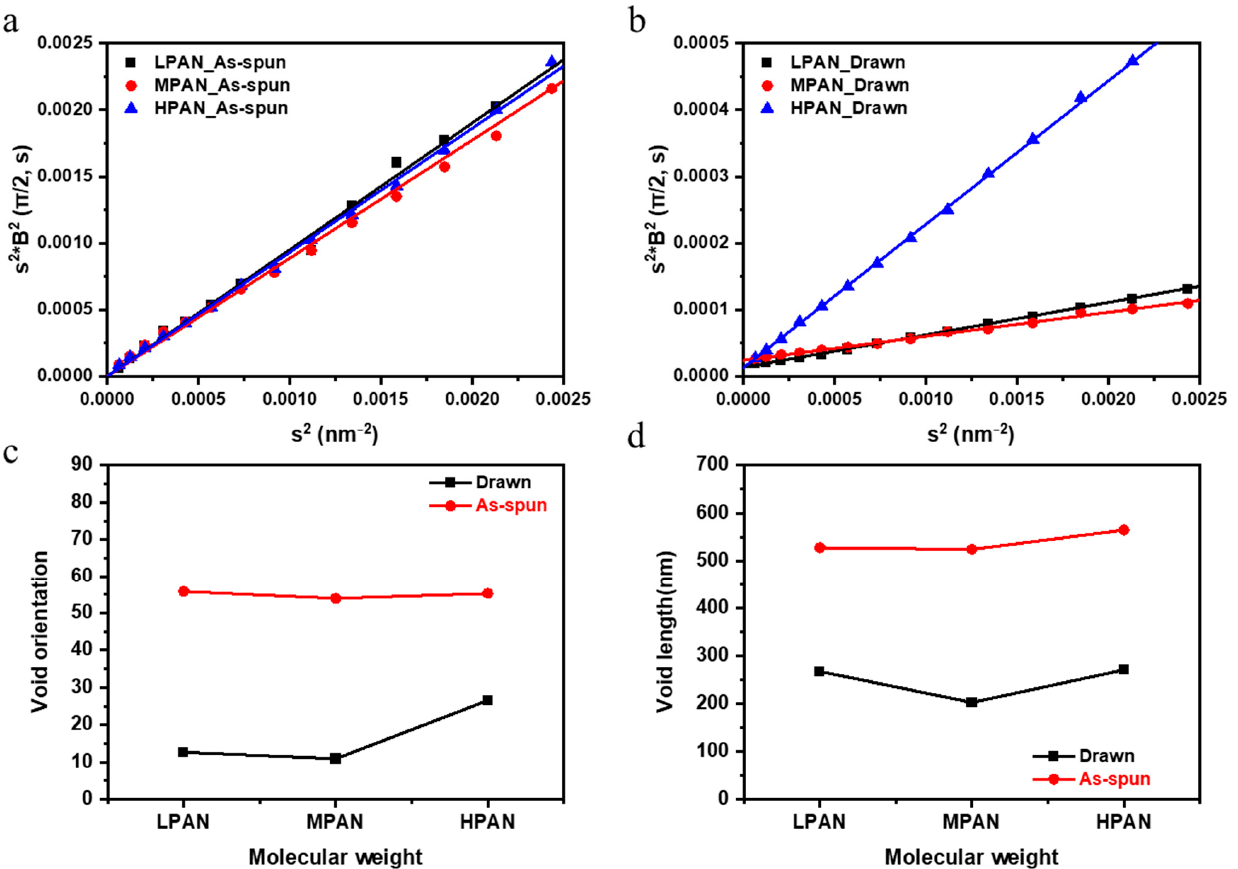
Figure 8. Two-dimensional small-angle X-ray scattering (SAXS); Ruland’s streak data for ( a ) as-spun fibers, ( b ) drawn fibers, ( c ) void length, and ( d ) void